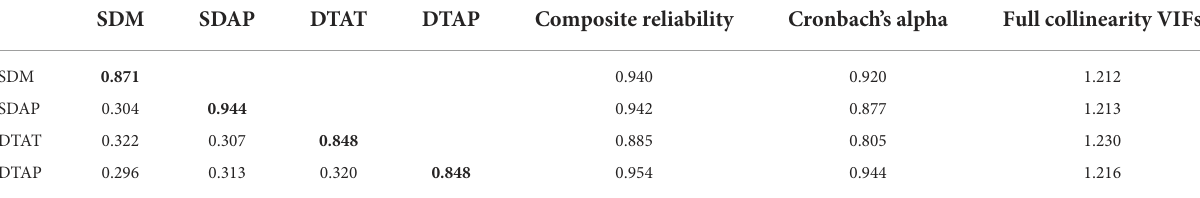
TABLE 3 Correlations and the square root of AVEs.